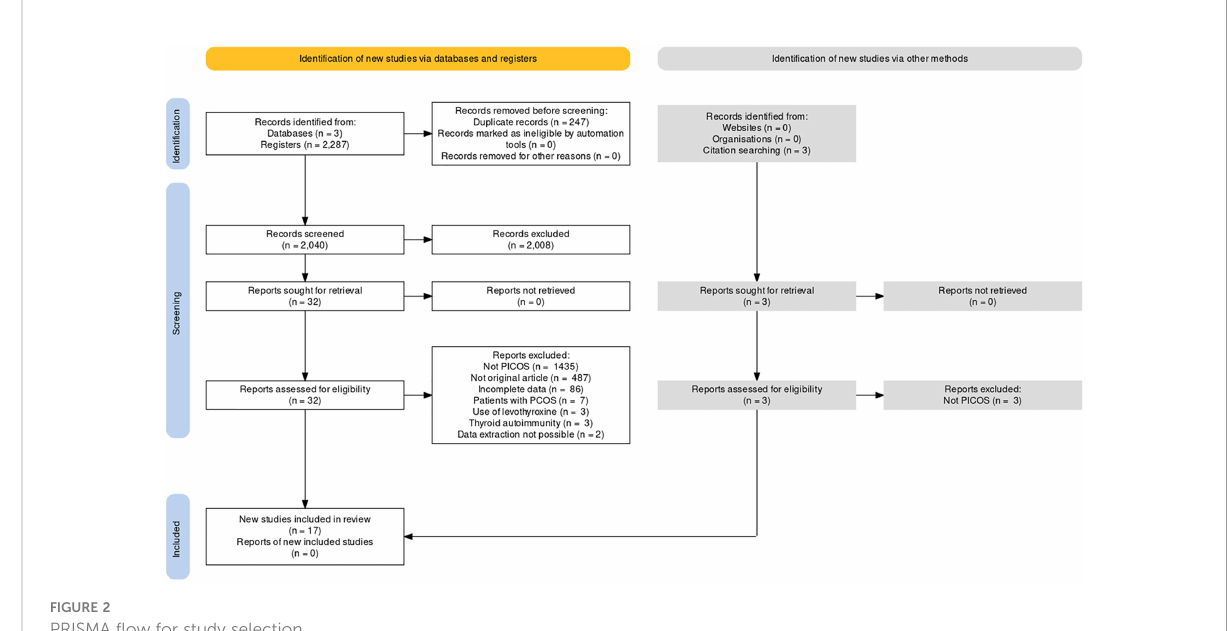
FIGURE 2 PRISMA fl ow for study selection.